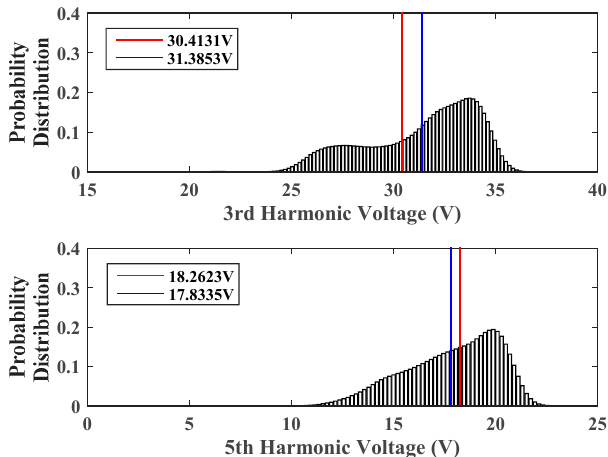
Figure 12. The probability distributions of the measured data.